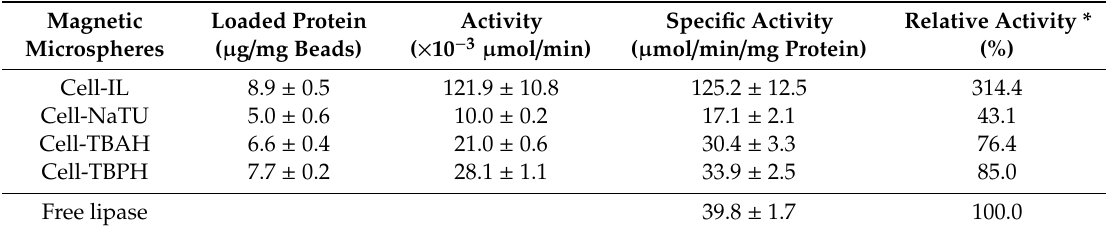
Table 4. Activity of lipases immobilized on the magnetic cellulose